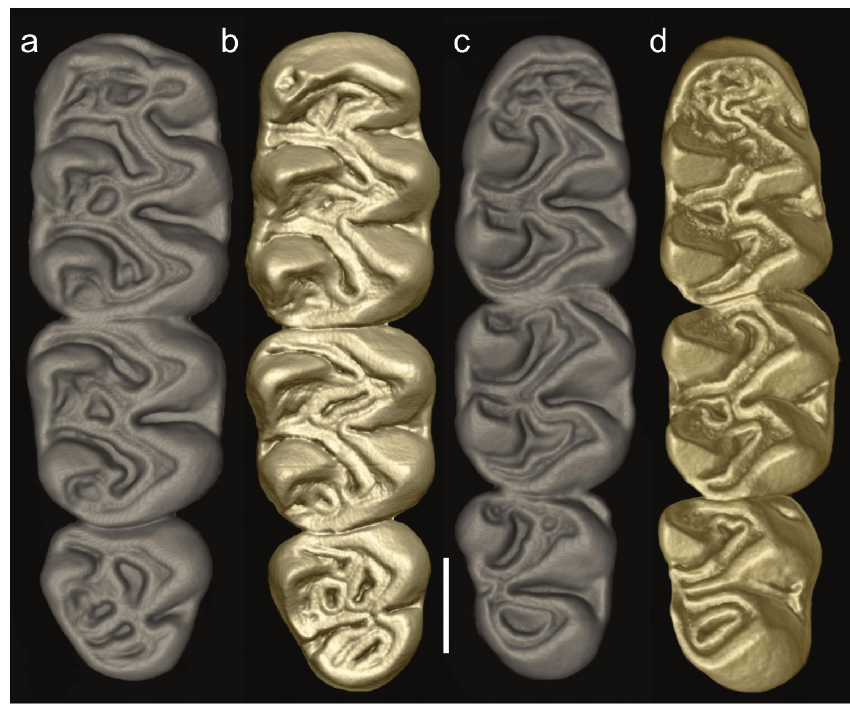
Figure 9. Three-dimensional reconstructions of the occlusal view of right upper ( a, b ) and lower ( c, d ) toothrows based on mi- cro-CT data of the holotypes of Mindomys kutuku sp. nov. ( a, c MECN 5809; Cordillera de Kutukú, Ecuador) and Mindomys ham- mondi ( b, d NHMUK 13.10.24.58; Mindo, Ecuador). Scale bar: 1